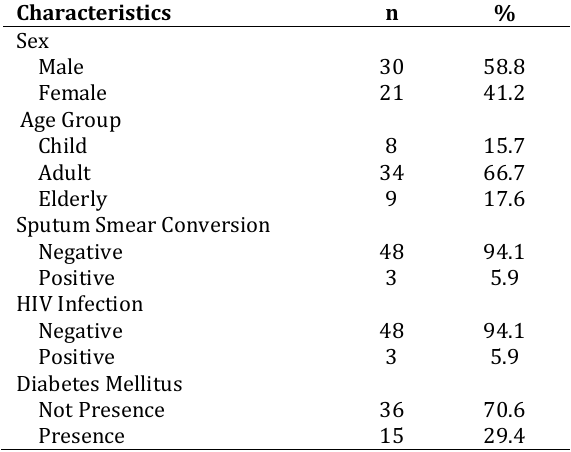
Table 1. Characteristics of respondents (n=51)